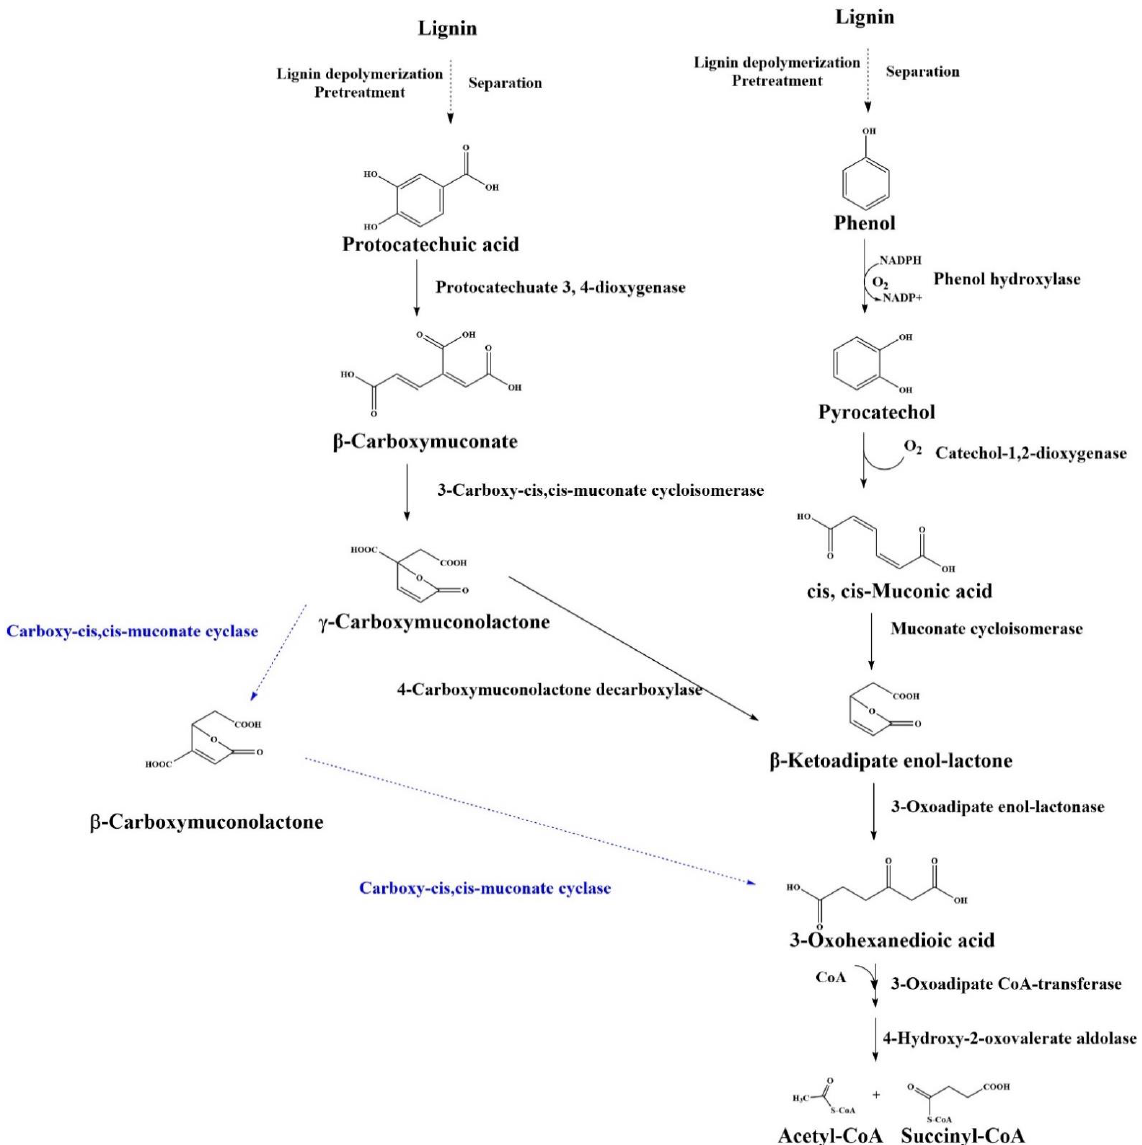
Figure 5. The degradative pathways of protocatechuic acid and phenol through β -ketoadipate. The lignin-derived aromatic compounds are degraded to central metabolites via these pathways for biosynthesis and energy. The enzymes are from Sphingobium sp. strain SYK-6, with the exception of carboxy-cis,cis-muconate cyclase from eukaryotes [91].